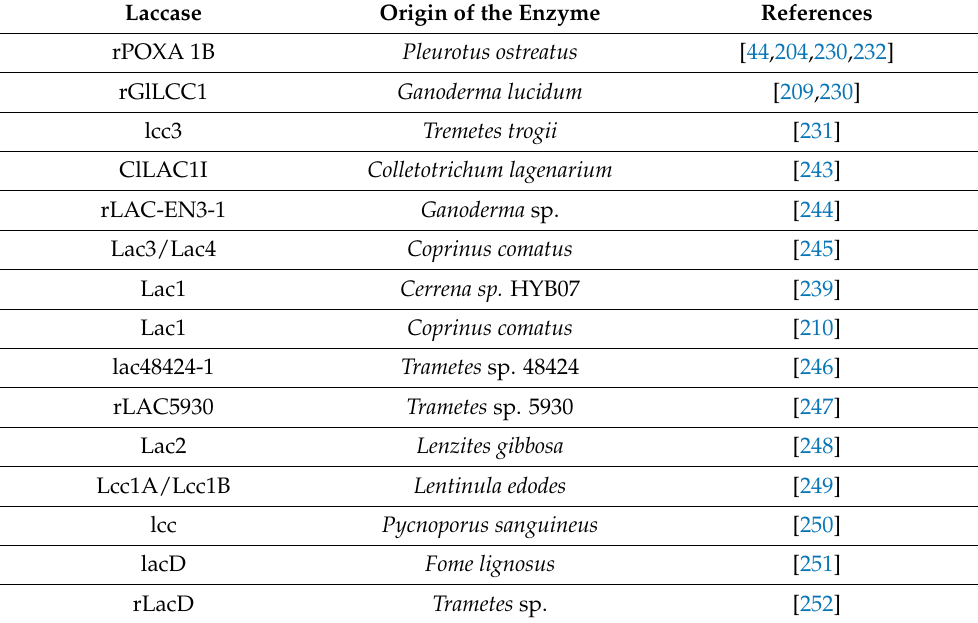
Table 6. Some fungal laccases heterologous expressed in P. pastoris